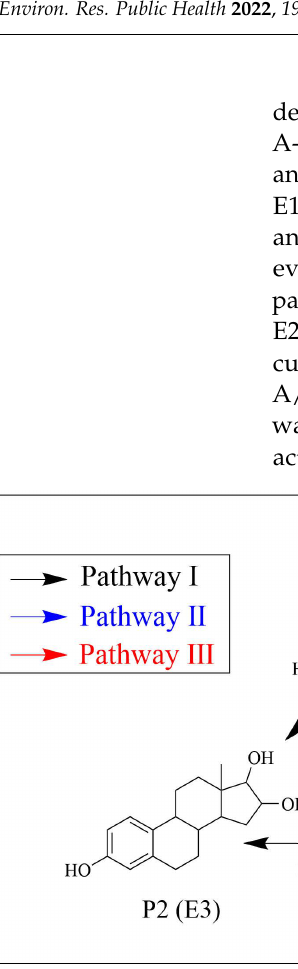
Figure 6. Possible pathways for 17 β -estradiol degradation by strain